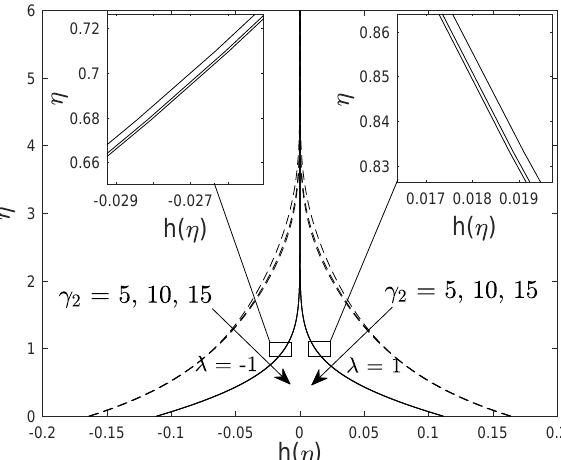
Figure 4. Slip velocity along the x -direction for diverse values of γ 2 with λ = − 1,1.